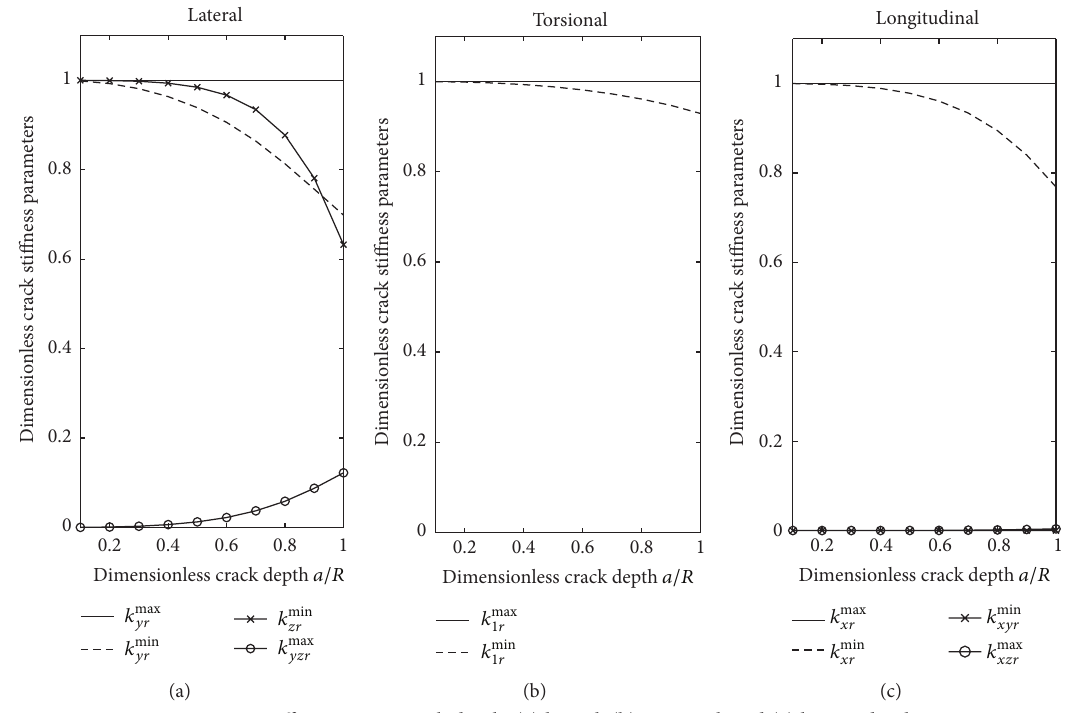
Figure 4: Stiffness versus crack depth: (a) lateral, (b) torsional, and (c)